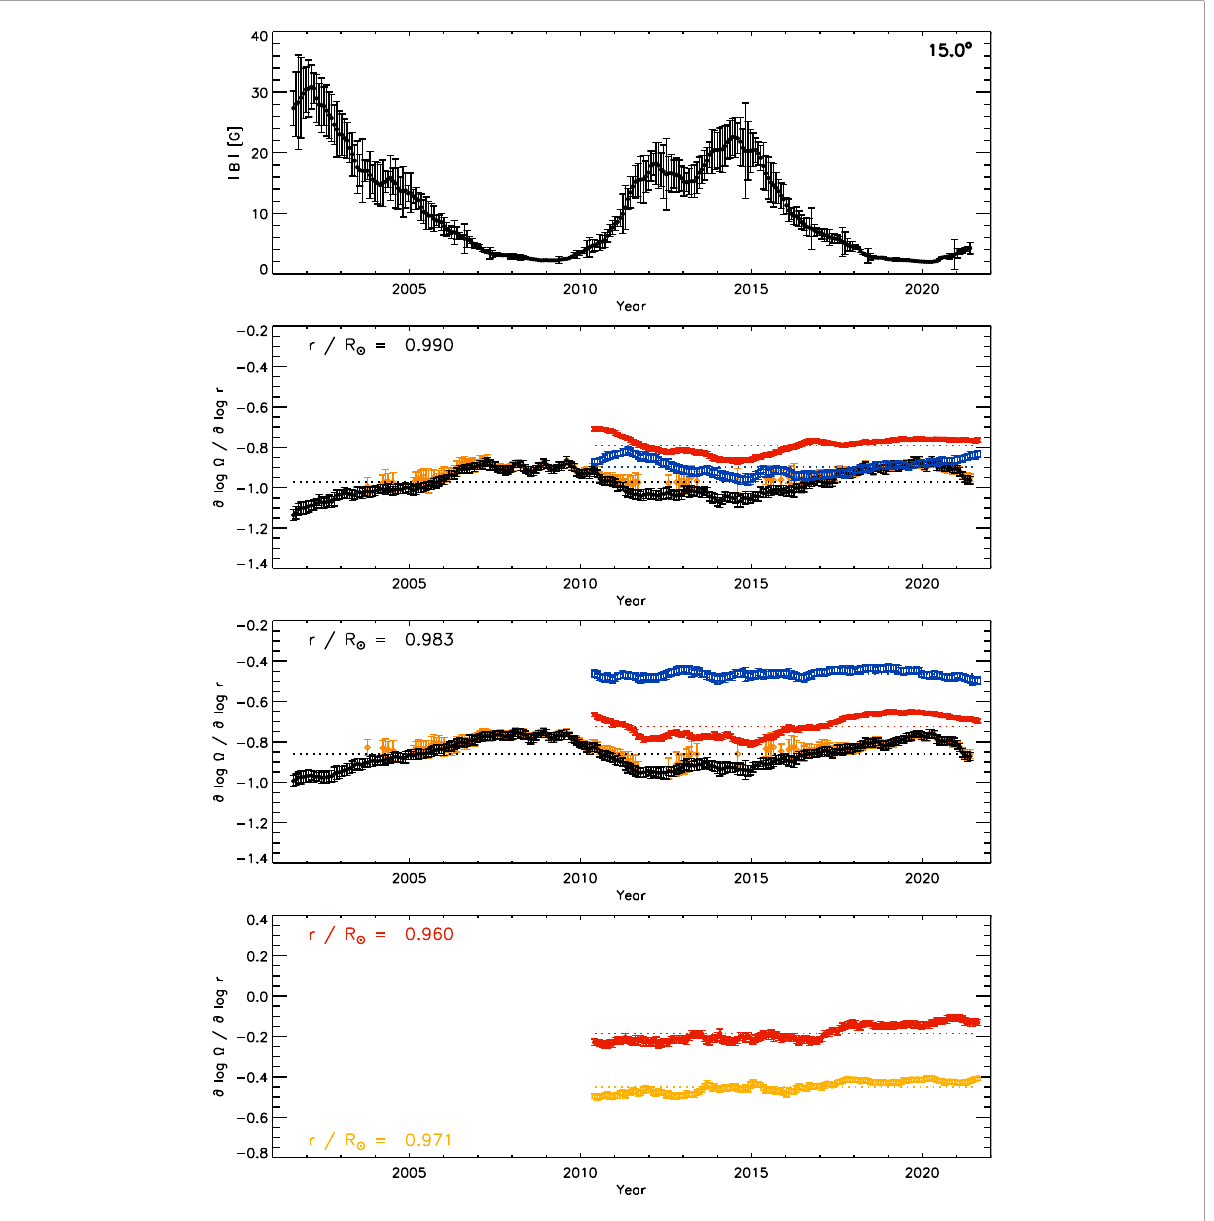
FIGURE 10 The temporal variation of the magnetic activity index, MAI, (top) and that of the corrected radial gradient of the solar rotation rate at three depths (2nd: .990 R ⊙ , 3rd: .983 R ⊙ , bottom: .960 R ⊙ ) at 15° latitude averaged over both hemispheres derived from 15°-tile RDA (black diamonds: GONG, blue squares: HMI) and 30°-tile RDA (red circles: HMI) smoothed with a rectangular boxcar over 13 CRs. The values of the GONG quiet-region subset are included (orange open diamonds). The bottom panel includes the variation at .971 R ⊙ (orange open circles). Compare with Figure 8 .